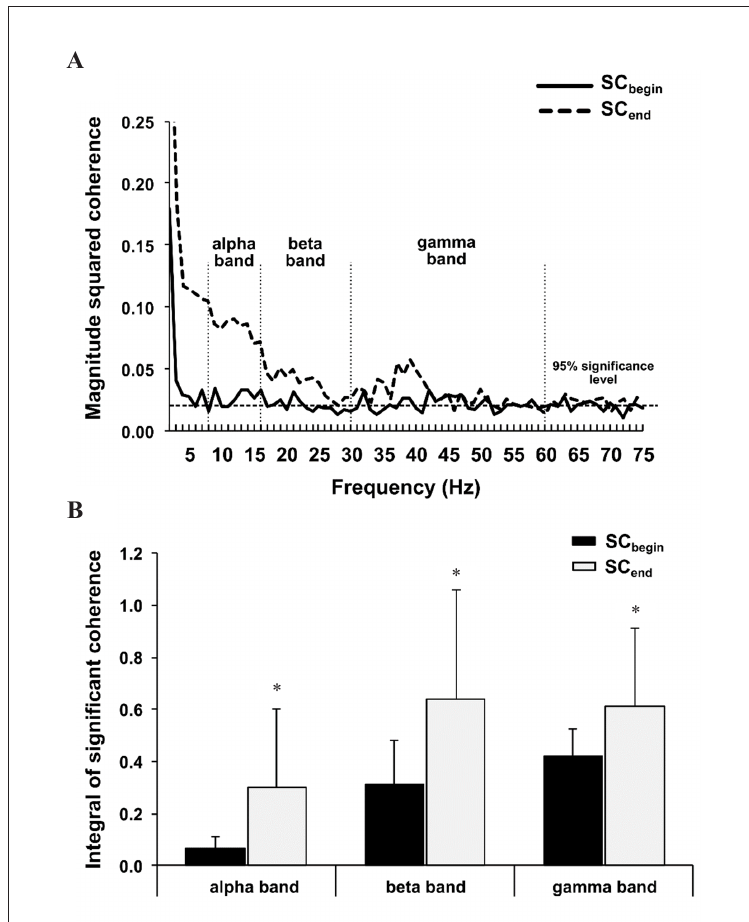
Note. * p < .05, compared with SC begin .